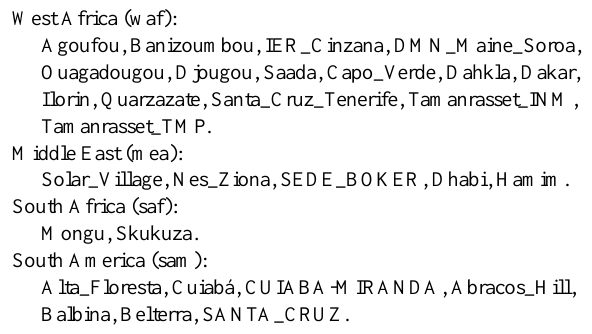
Table 2. AERONET sites used in this